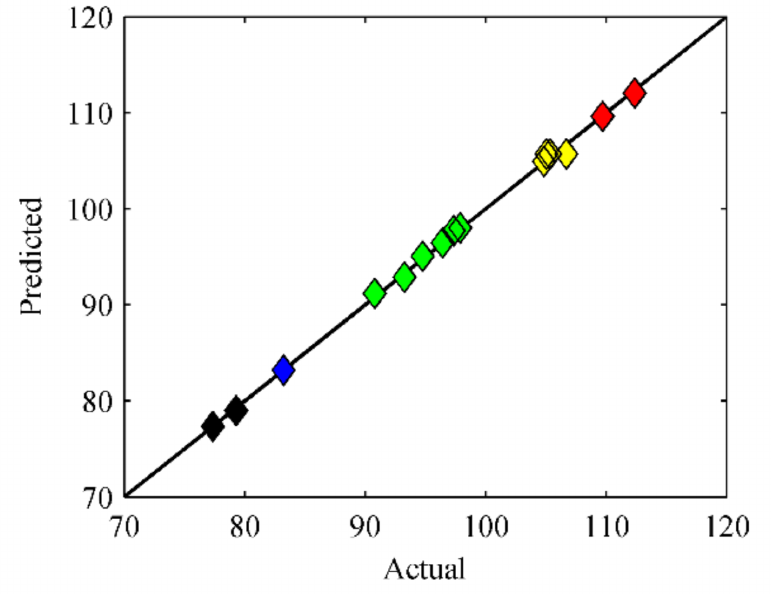
Figure 4. Corresponding relationship between the predicted and actual value of average desulfuriza- tion rate (Different colors indicate different ranges of actual value of average desulfurization